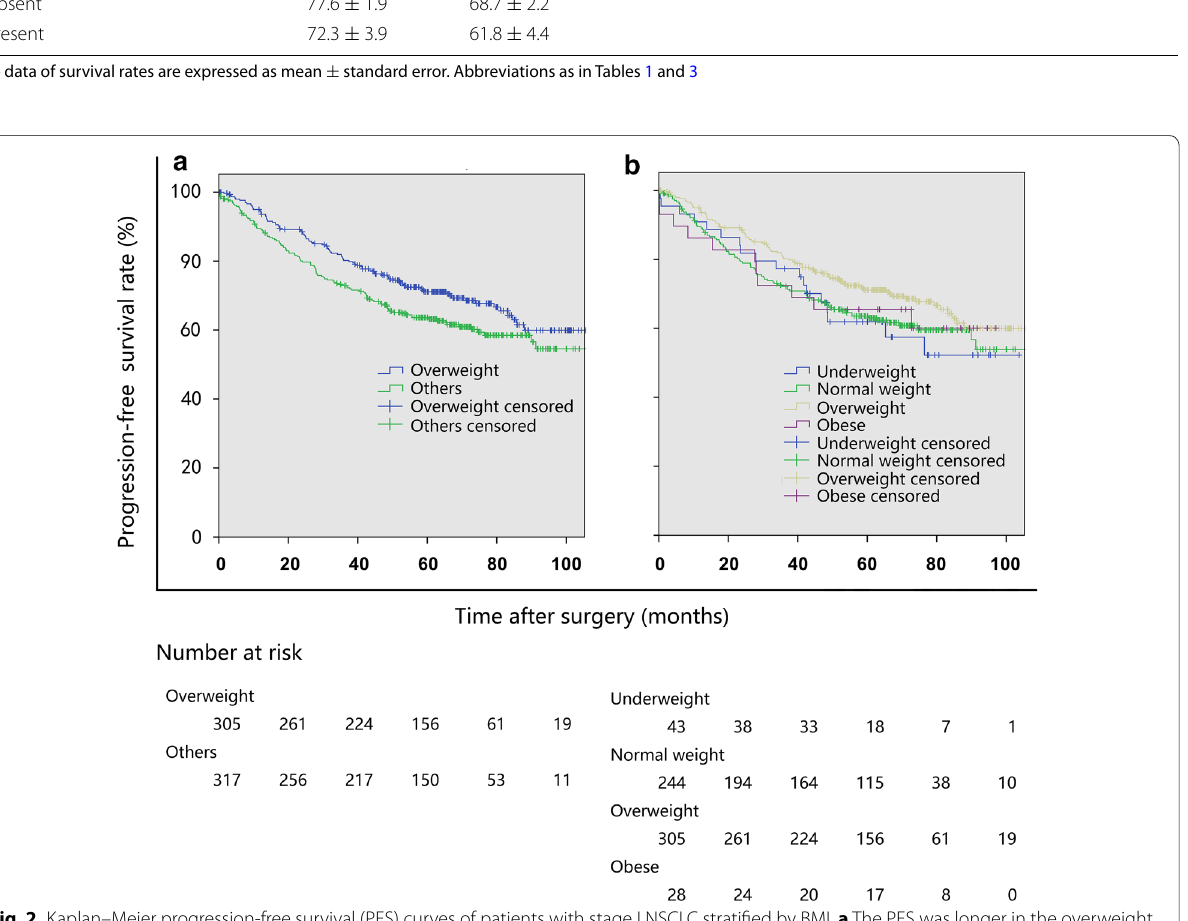
0.034). b The PFS was longer in the overweight group than in the normal weight group ( P =